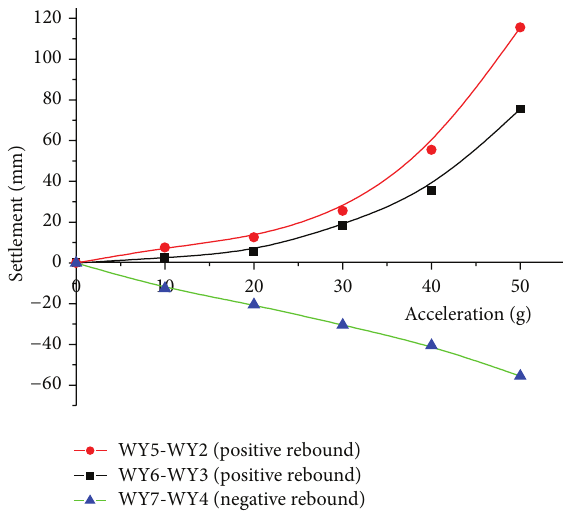
Figure 13: The settlement of layer number 5 in different accelera-